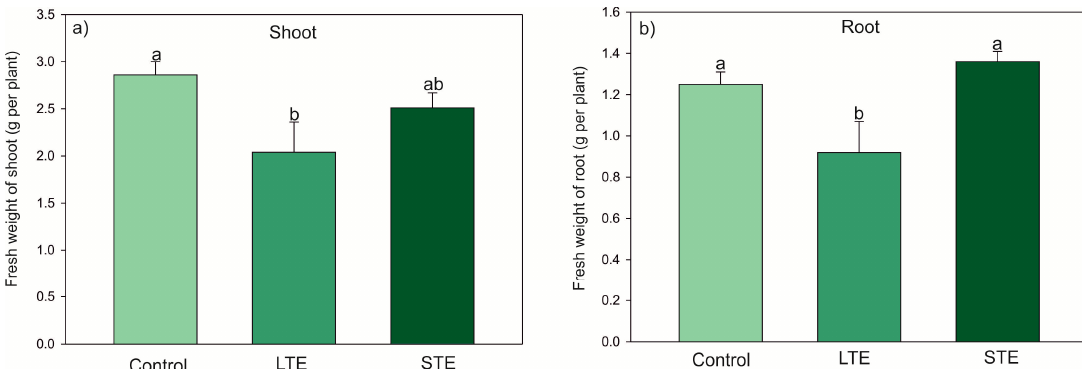
Figure 1. Biomass of ( a ) shoots and ( b ) roots of Glycine max in control plants (Control) and under Sr application (long-term (LTE) and short-term (STE) exposure) with standard error (SE) (for each organ, n = 5). The data followed by the same letters within the same plants’ organs are not significantly different.